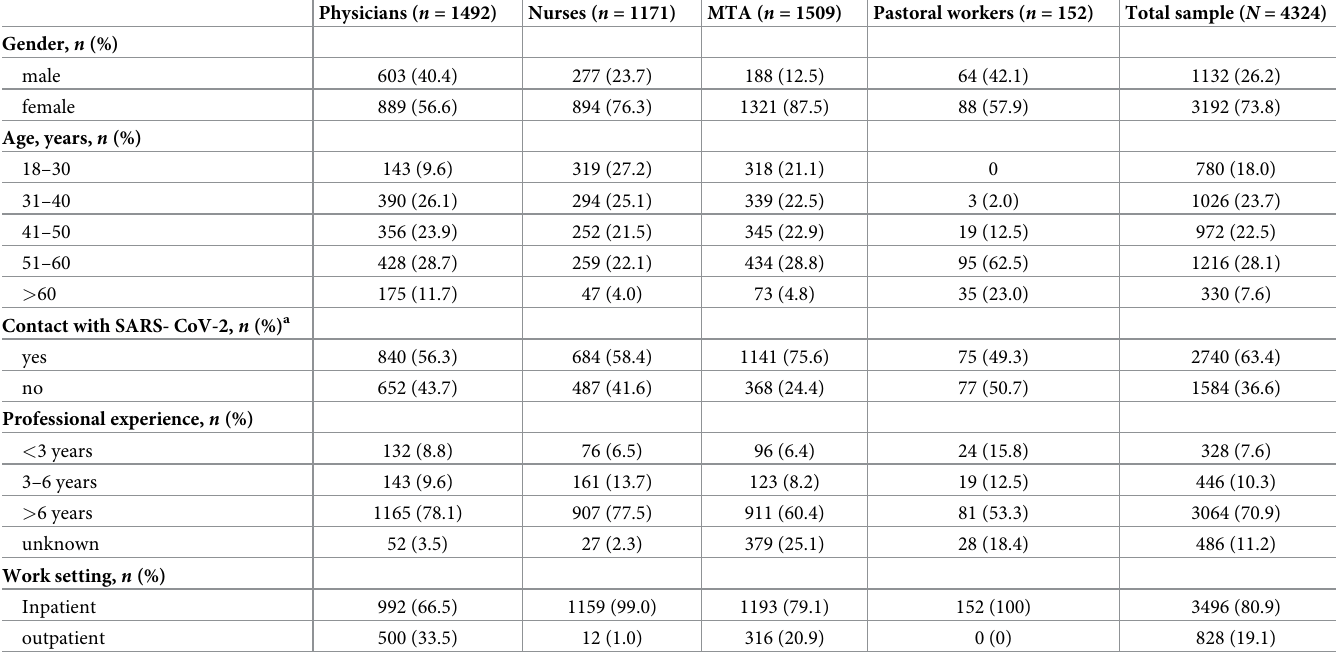
Table 1. Descriptive statistics for sociodemographic and occupational variables for the different professions. Physicians ( n =